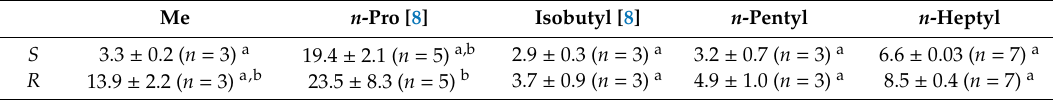
Table 2. Cytotoxicity against the HL60 cell of ficifolidione and its derivatives (IC 50 ( µ M); mean ±